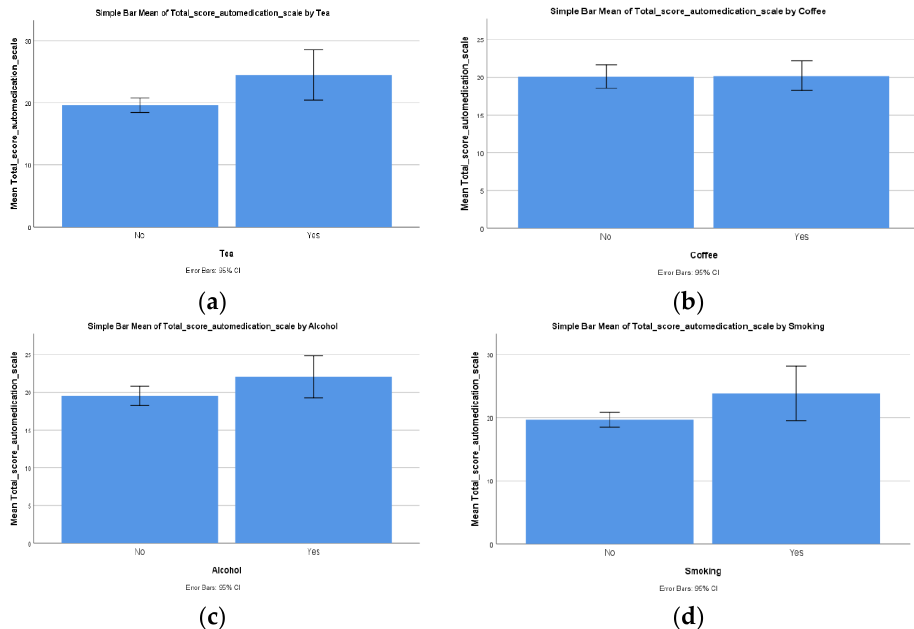
Figure 3. Differences regarding the total score of self-medication scale between the two ( a ) tea consumption groups, ( b ) coffee consumption groups, ( c ) alcohol consumption groups and ( d ) smoking habit groups.